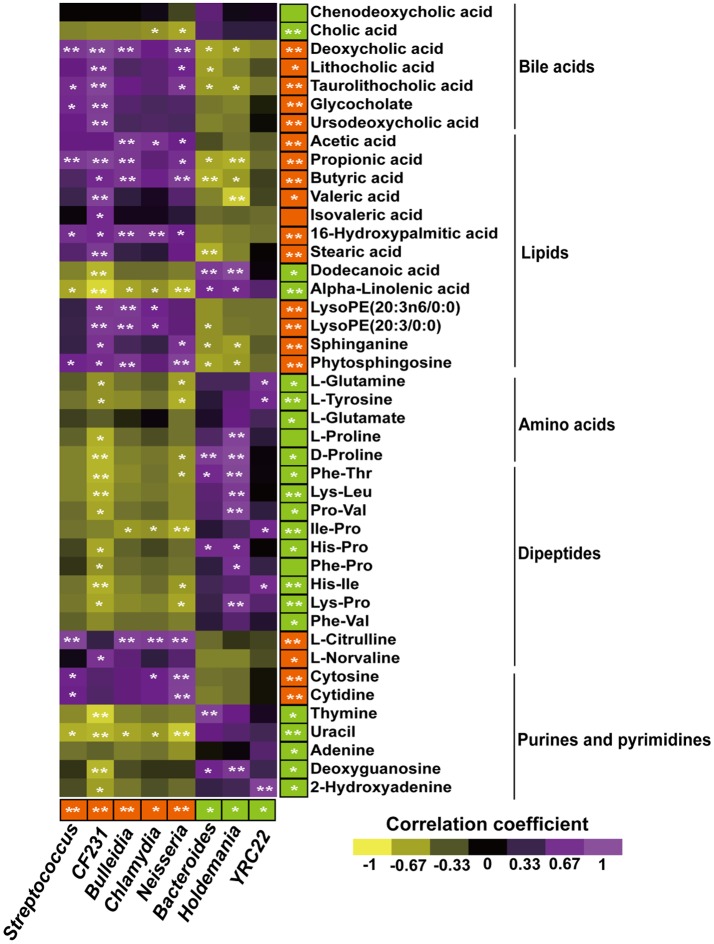
Pearson's correlation analysis of colonic metabolites and colonic bacterial genus-level taxa in Landrace and Meihua samples. Bacterial genera and colonic metabolites enriched in Landrace or Meihua samples are colored red and green, respectively. An asterisk in the colored box indicates that a genera or metabolite is significantly enriched in Landrace (red) or Meihua (green) samples. Correlations with P ≤ 0.05 are shown. Yellow represents a significant negative correlation (P < 0.05), purple represents a significant positive correlation (P < 0.05), and black represents no significant correlation (P > 0.05). Orange color with *represents a higher value in Landrace (P < 0.05), and **P < 0.01.